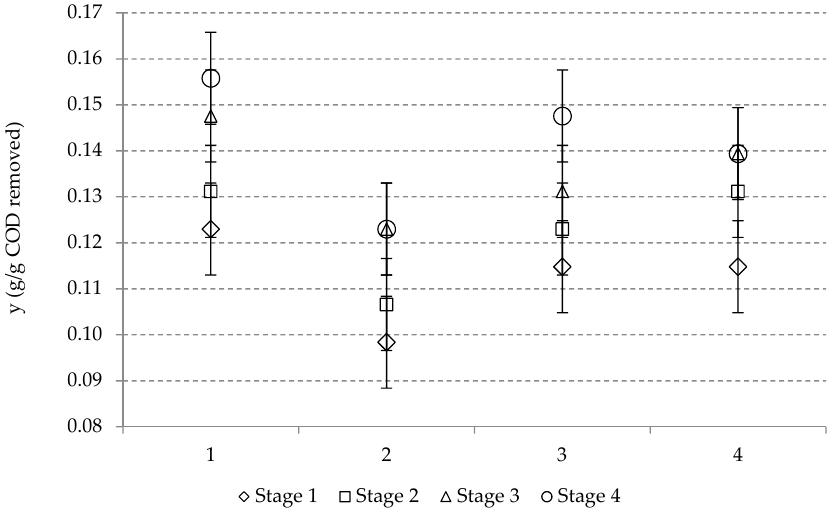
Figure 6. Biomass growth yield coefficients (y) experimental stages.